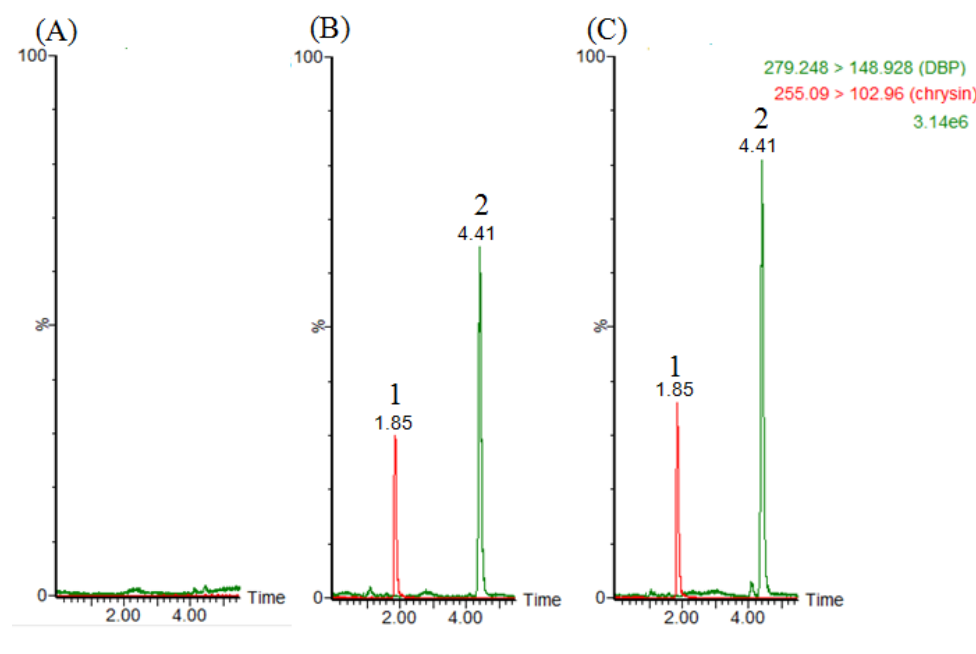
Figure 2. Chromatograms of ( A ) blank plasma after protein precipatation, ( B ) blank plasma spike with DBP (1 μ g/mL) and chrysin (1 μ g/mL) and ( C ) real sample collected at 5 min after DBP administration (30 mg/kg, i.v.) with chrysin (1 μ g/mL). 1: chrysin (internal standard), 2: